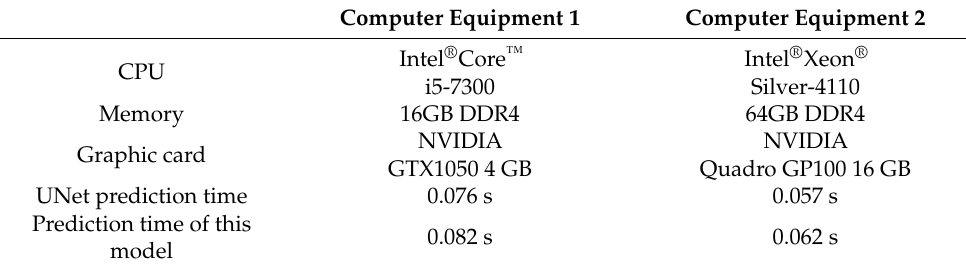
Table 5. Validation dataset performance comparison of various models.